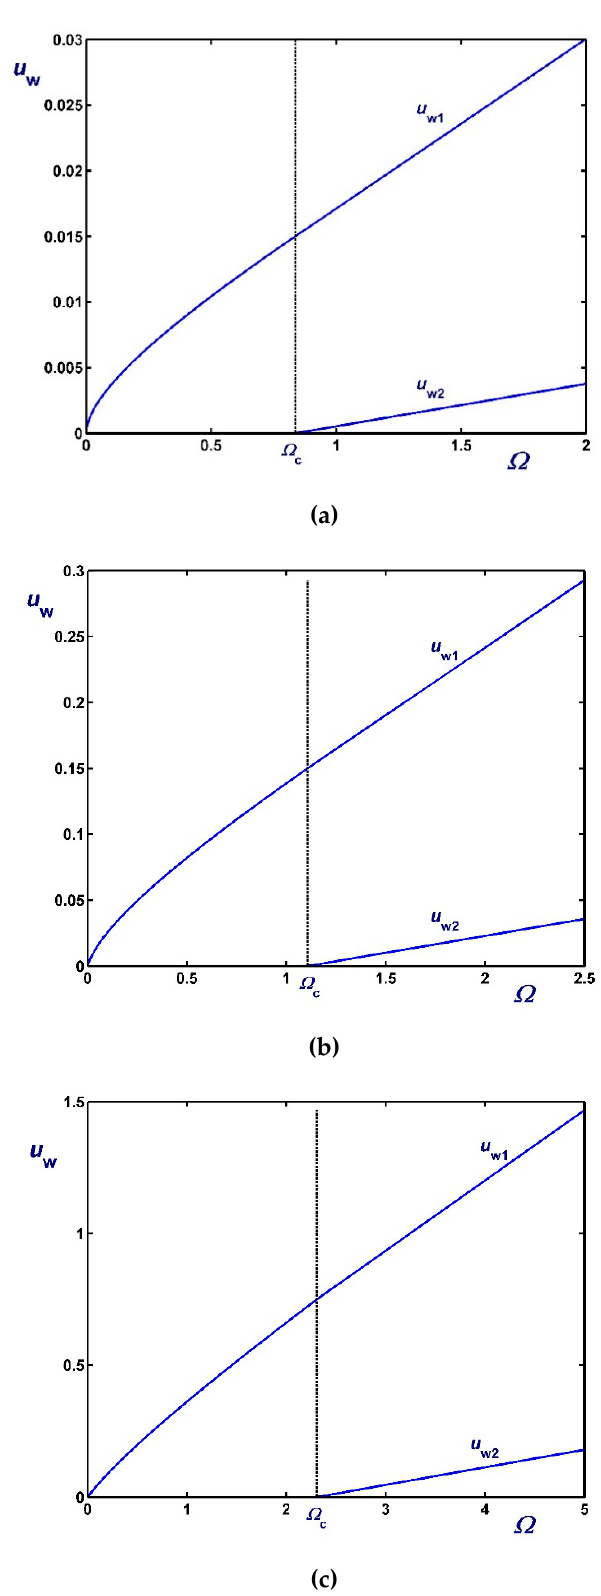
κ= κ = 0.5 and di ff erent slip numbers with non-zero slip yield stress τ ∗ and different slip numbers with non-zero slip yield stress Figure 10. Slip velocities for